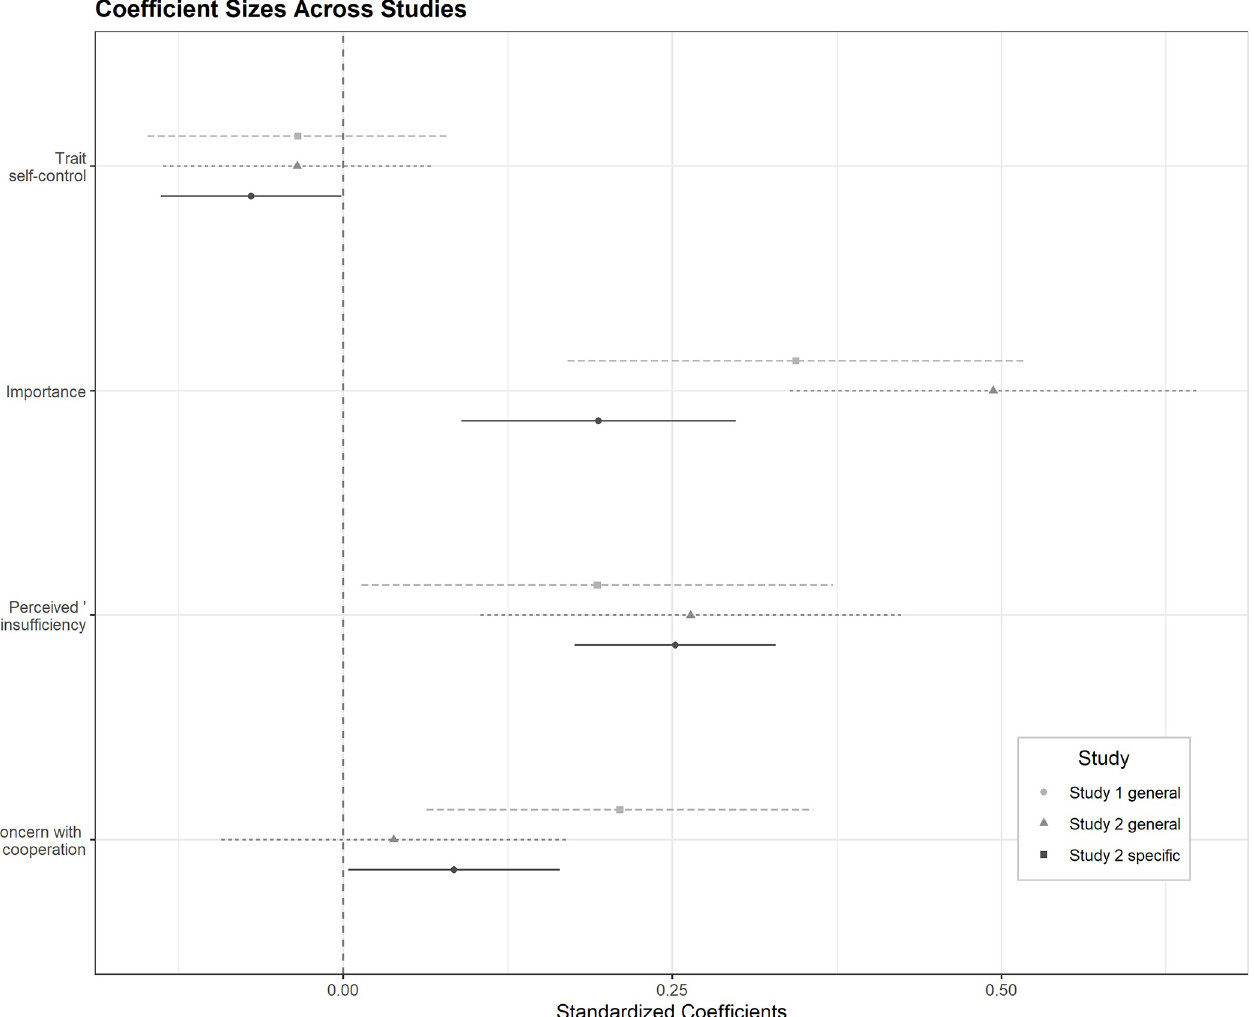
Fig 1. Coefficient sizes and associated 95% confidence intervals across both studies and outcome variables for predictors of interest. Note . Polit. orientation = political orientation, general = general support for climate policy, specific = support for specific climate policies. In study 1, age was not selected by elastic net and is, therefore, not included